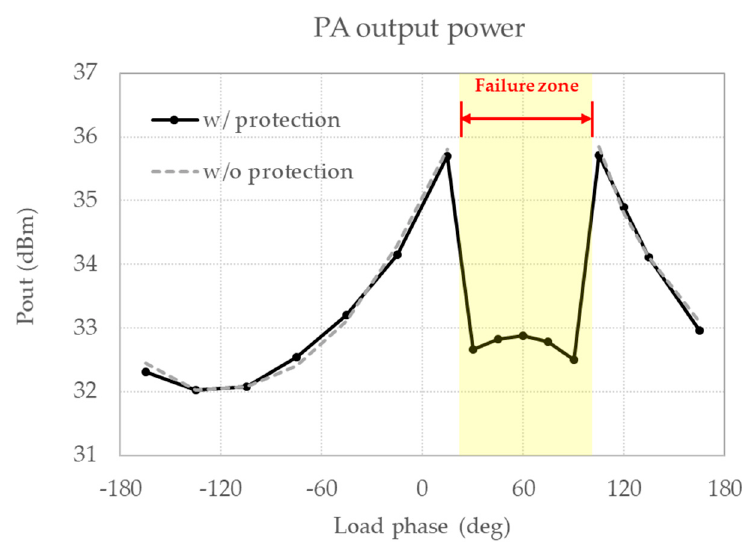
Figure 10. Measured output power comparison with and without protection circuit. (Frequency = 2017.5 MHz, collector voltage (Vcc) = 5.5 V, | Γ L | = 0.7).